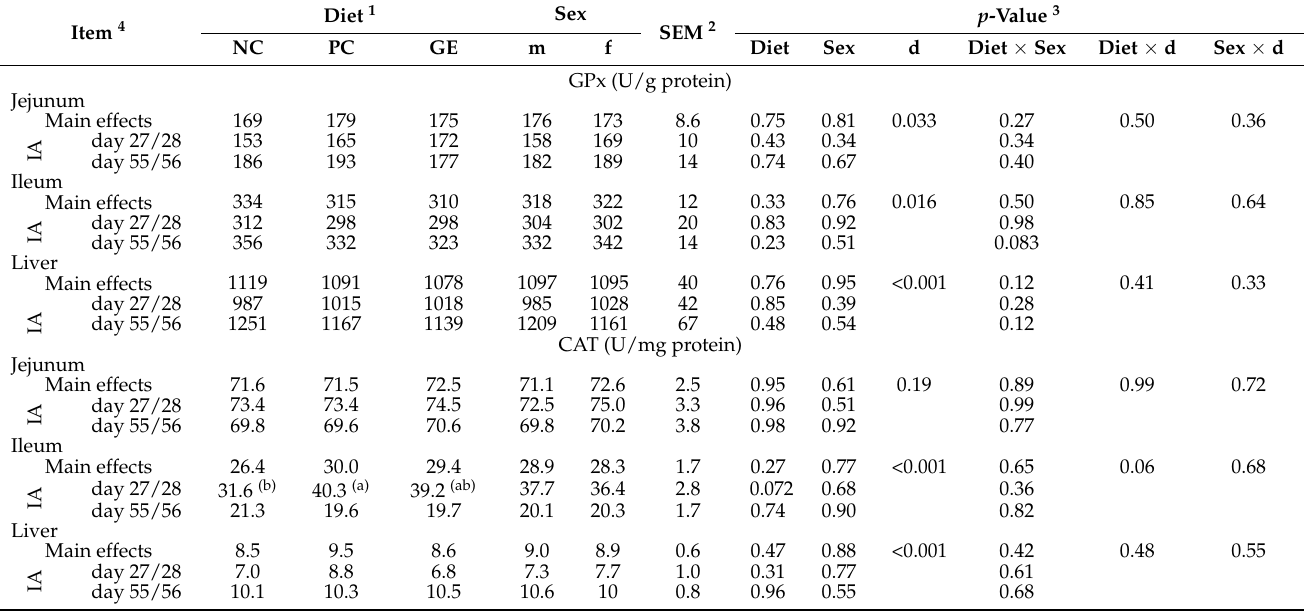
Table 4. Effect of dietary GE supplementation on antioxidant enzyme (GPx and CAT) activity from the intestinal tissues and liver of the weaning piglets compared to NC and PC.